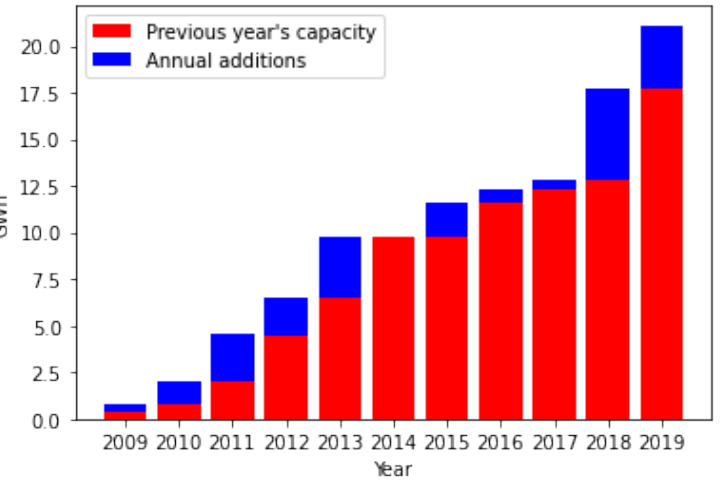
Figure 1. CSP Thermal Energy Storage Global Capacity and Annual Additions, 2009–2019